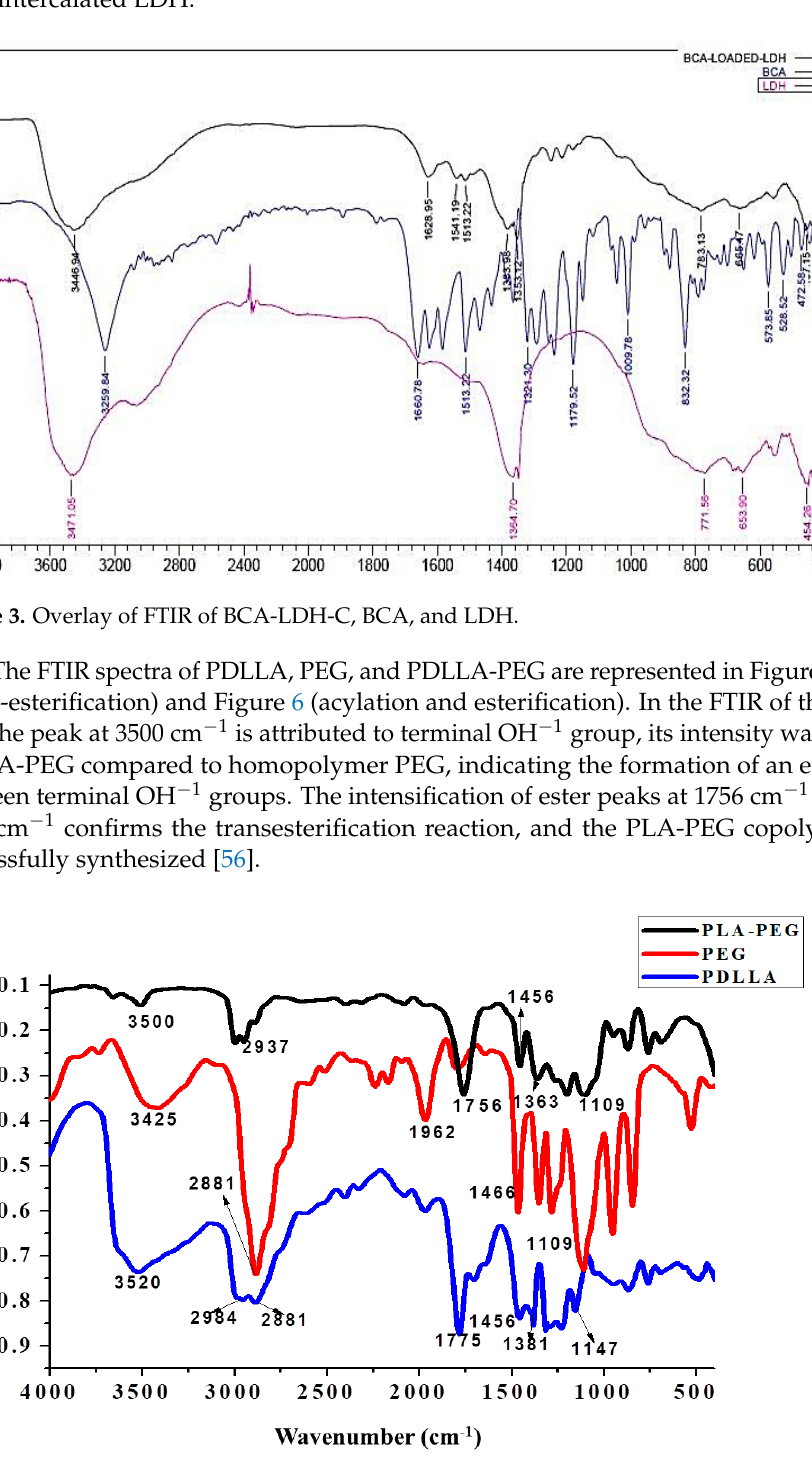
Figure 5. Transesterification reaction of PLA and PEG.